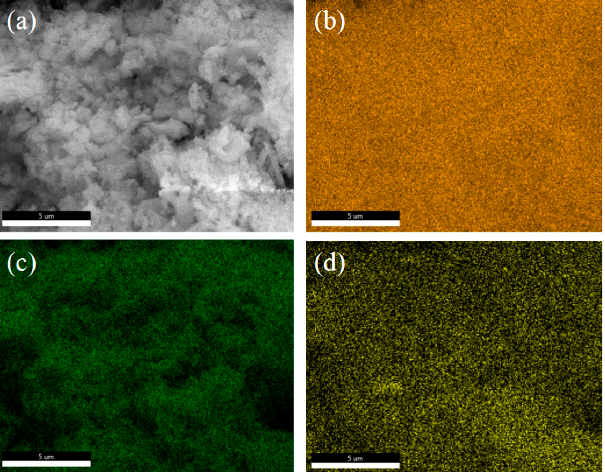
Figure 8. SEM micrographs before and after the 10 cycles: ( a ) limestone after the 1st calcination; ( b ) BF 0.5 -Al after the 1st calcination; ( c ) limestone after the 11th calcination; and ( d ) BF 0.5 -Al after the 11th calcination.